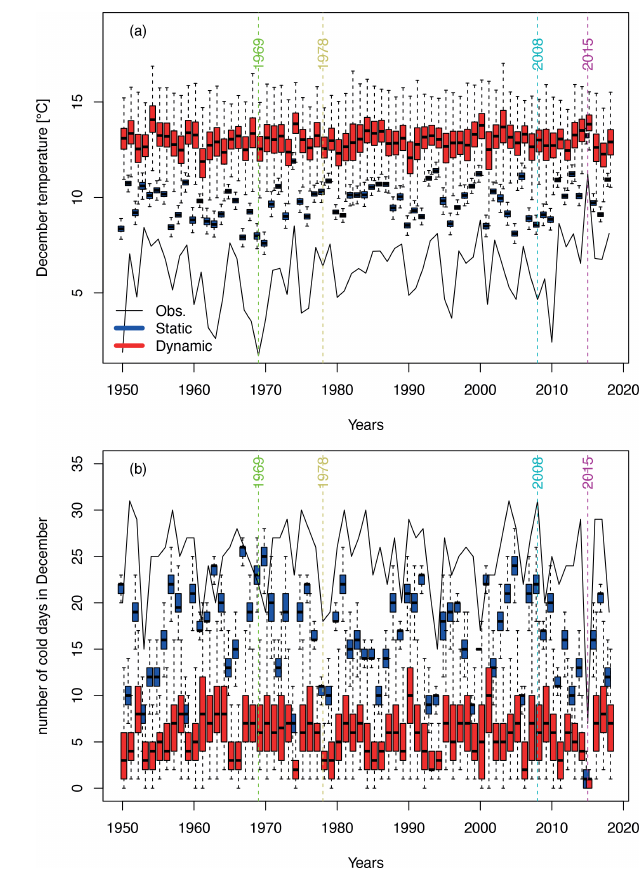
Figure 4. (a) Daily maximal temperature in December from 1950 to 2018. The black line shows E-OBS observations. The boxplots represent the ensemble variability of the simulations of the static (blue) and the dynamic (red) SWG for each year. The boxes of the boxplots indicate the median ( q 50) and lower ( q 25) and up- per ( q 75) quartiles. The upper whiskers indicate min [ max( T ) , 1 . 5 × ( q 75 − q 25)]. The lower whisker has a symmetrical formulation. The points are the simulated values that are above or below the de- fined whiskers. Panel (b) is the same as (a) but for the number of cold days. The coloured vertical lines indicate the coldest Decem- ber (green), a median December (yellow), a December with 31 cold days (cyan) and the warmest December